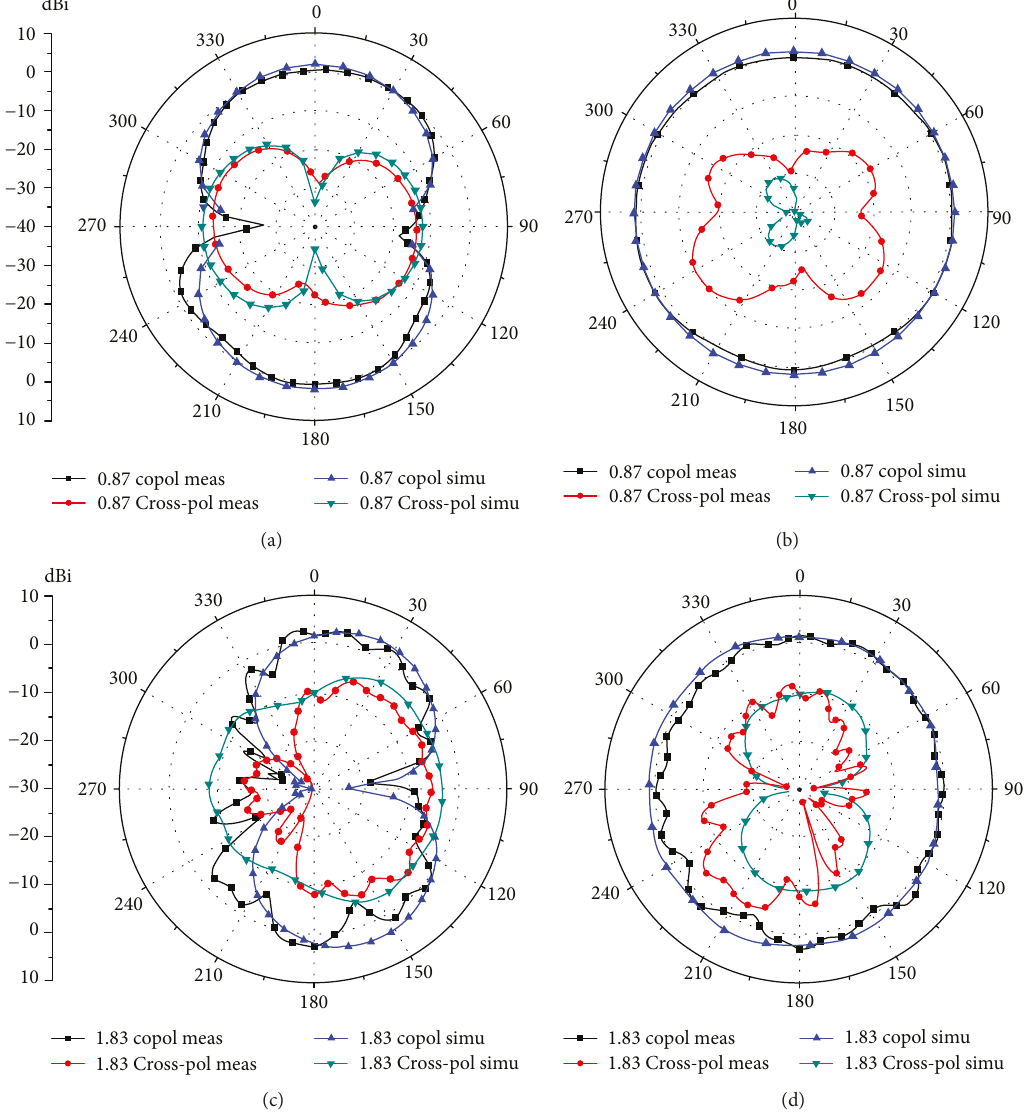
Figure 6: Simulated and measured 2D radiation pattern. (a) 0.87 GHz E -plane ( XOZ -plane), (b) 0.87GHz H -plane ( YOZ -plane), (c) 1.83GHz E -plane ( XOZ -plane), (d) 1.83GHz H -plane ( YOZ